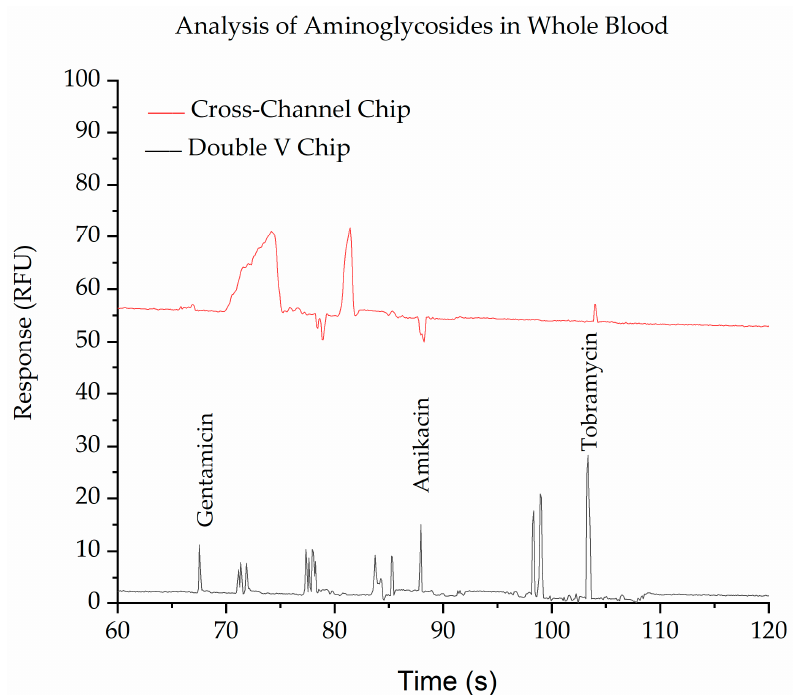
Figure 5. Electropherograms show the purification of whole blood spiked with 10 ppm of gentamicin, amikacin, and tobramycin and derivatized with fluorescamine using a cross-chip (red trace) and the Double V- chip (black trace). The BGE in the V-sample waste channel was 10 mM phosphate buffer, pH 11.5, while in the separation channel, it was 100 mM phosphate buffer, pH 11.5, with 0.5% HPMC. Applied voltages for injection were − 100, − 700, − 500, and +500 V for 60 s and for separation were − 300, +220, +2000, and − 400 V at reservoirs B, S, BW, and SW, respectively. For cross-channel, all channels were filled with 100 mM phosphate buffer, pH 11.5, with 0.5% HPMC. Applied voltages for injection were − 100, − 400, − 300, and +400 V at B, S, BW, and SW reservoirs, respectively, and separation voltages were − 200, +400, +1500, and +400 V at B, S, BW, and SW reservoirs. respectively.